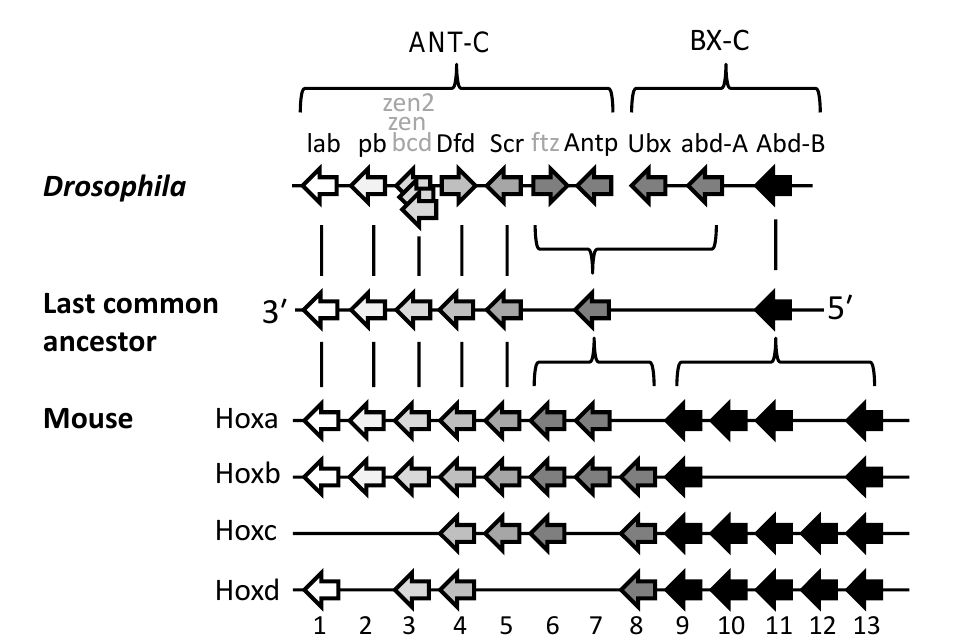
Figure 1. Homologous Hox gene clusters in Drosophila , mouse/human and, by inference, their common ancestor. The ancestor (the protostome–deuterostome last common ancestor, P-DLCA) may have had more than the seven genes shown here [4]. Genes that share the same numbers and shading intensities are most recently related by descent. Hox-derived genes in Drosophila that no longer function as true Hox genes are named in grey text. Arrows indicate directions of transcription (presumed for ancestor). ANT-C, Antennapedia complex; BX-C, Bithorax complex.